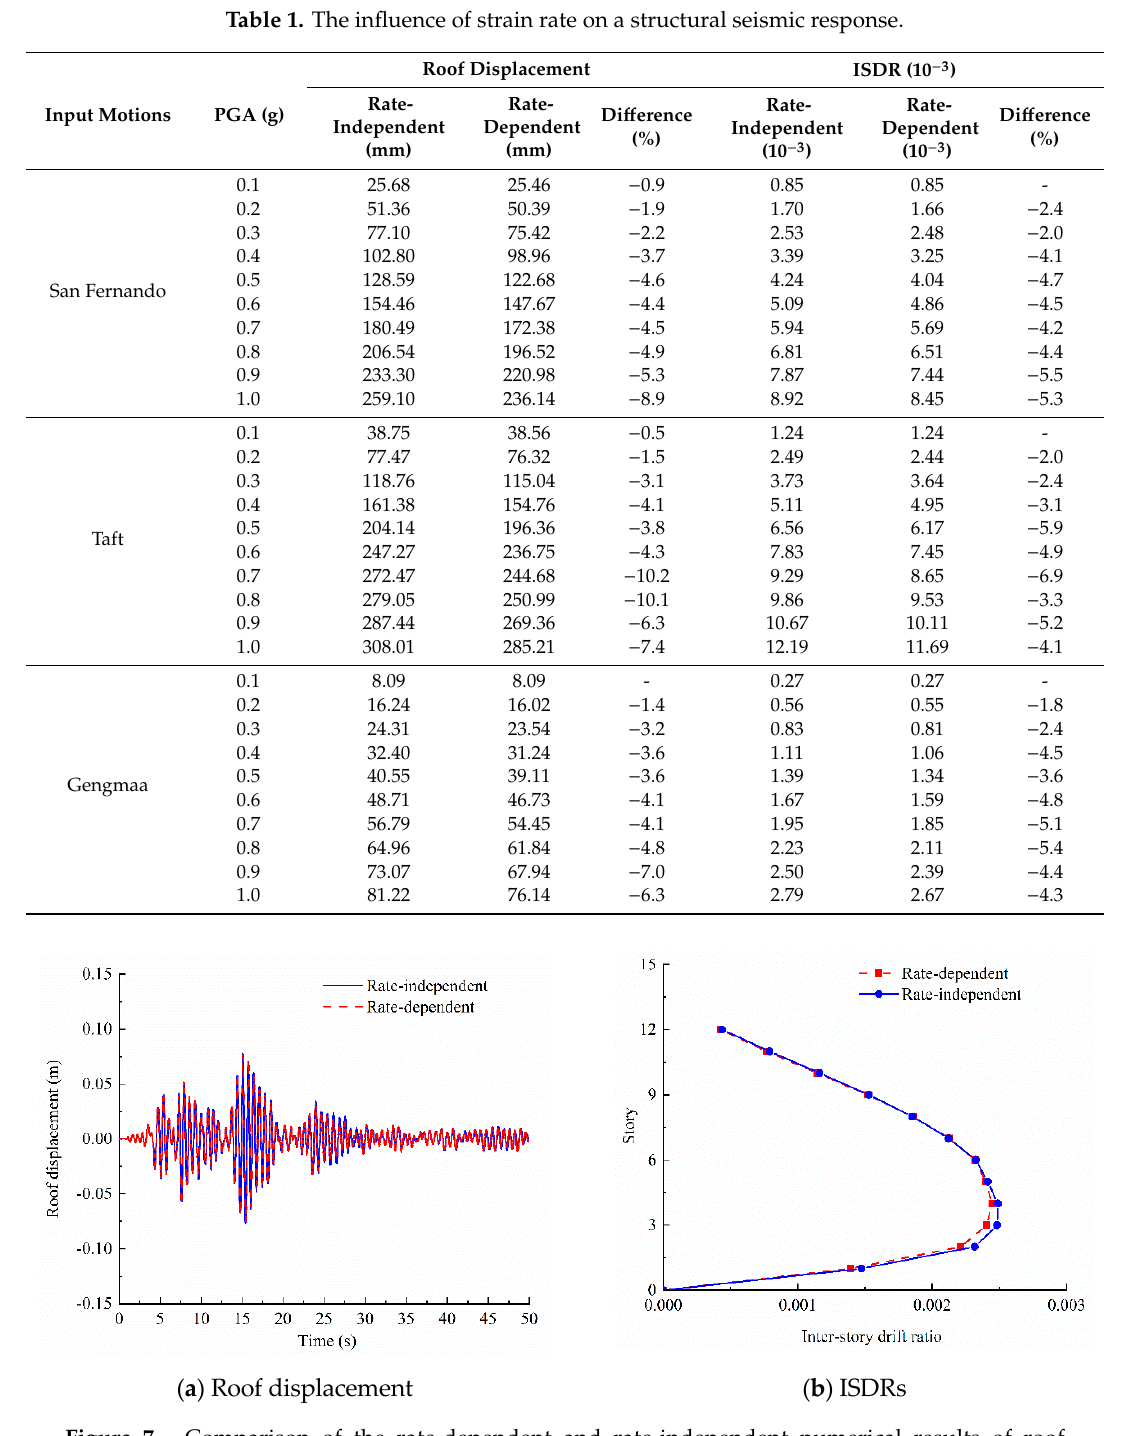
Figure 7. Comparison of the rate-dependent and rate-independent numerical results of roof displacement and an inter-story drift ratio (Taft PGA = 0.2 g).